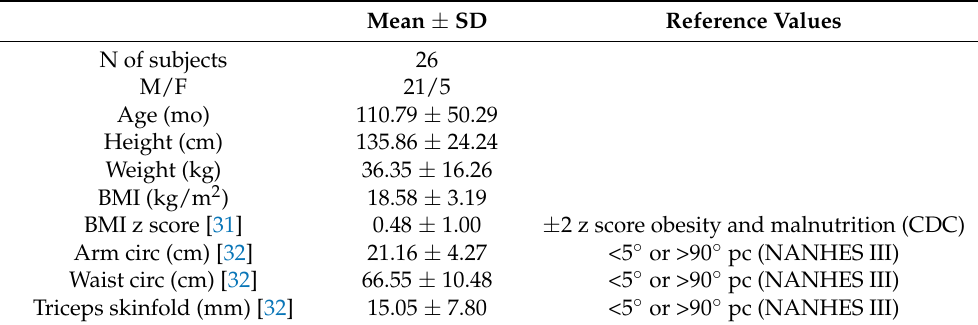
Table 1. Anthropometric data of MIS-C children at hospital admission. Values are expressed as mean ± standard deviation